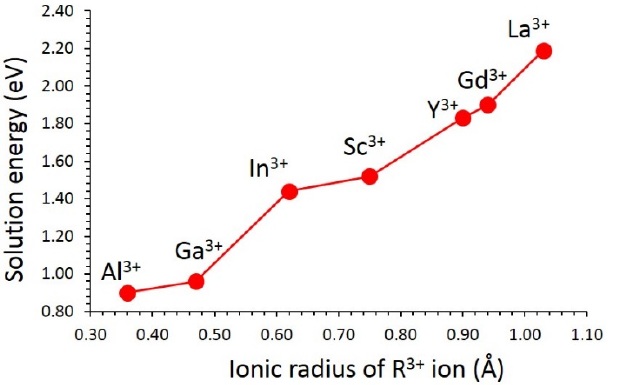
Figure 4. Calculated solution energies of trivalent dopants on the Si site.